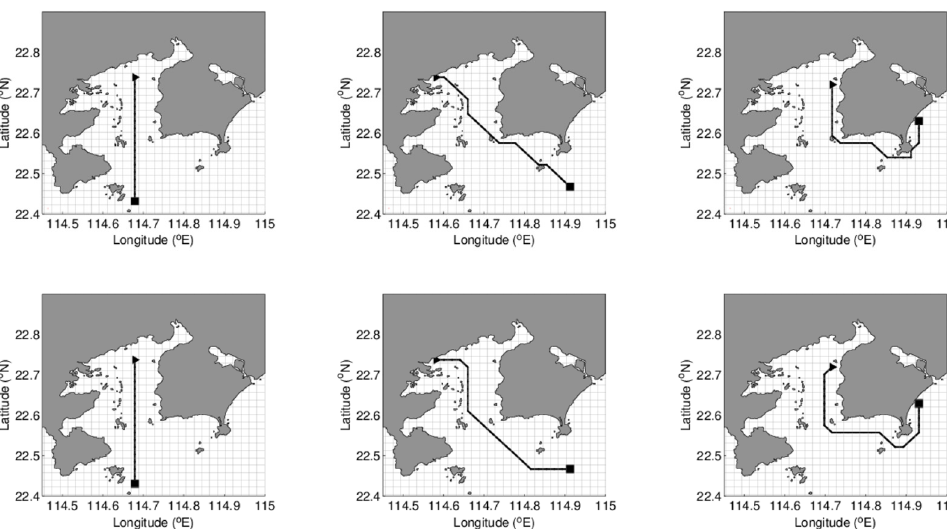
Figure 6. The comparison using the MDP ( top ) and the A* ( bottom ) algorithms for Cases 1 ( left ), 2 ( middle ), and 3 ( right ). The triangle is the starting point, and the square is the target. Table 4. The performance comparison between MDP and A*